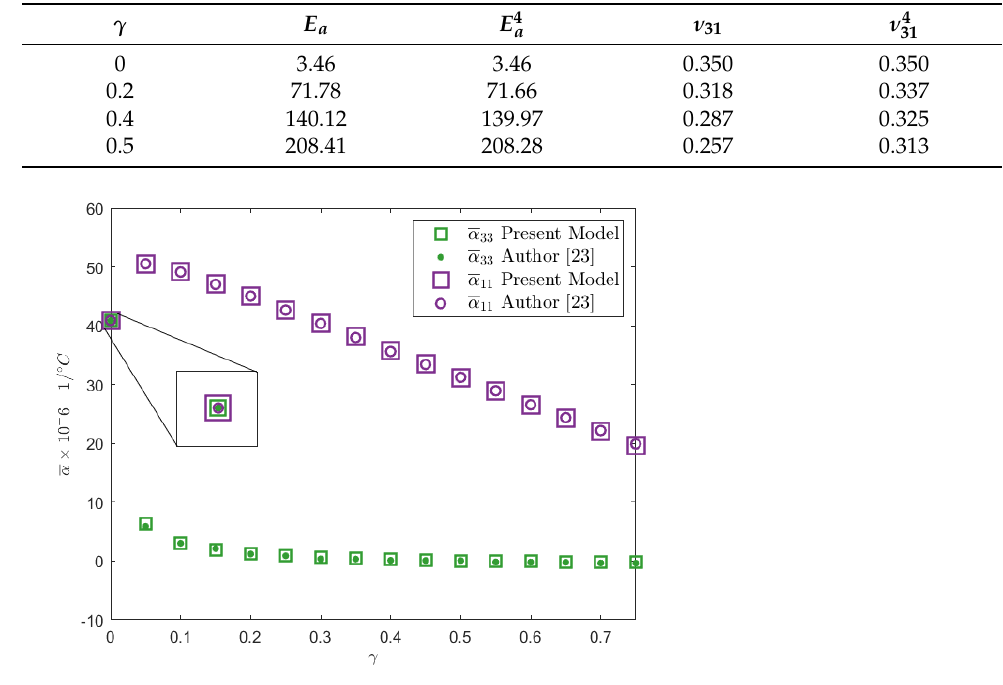
Table 5. Young’s modulus ( E 4 a ) and Poisson’s ratio ( ν 4 calculated by using the linear FEM approximation and those reported in [23].